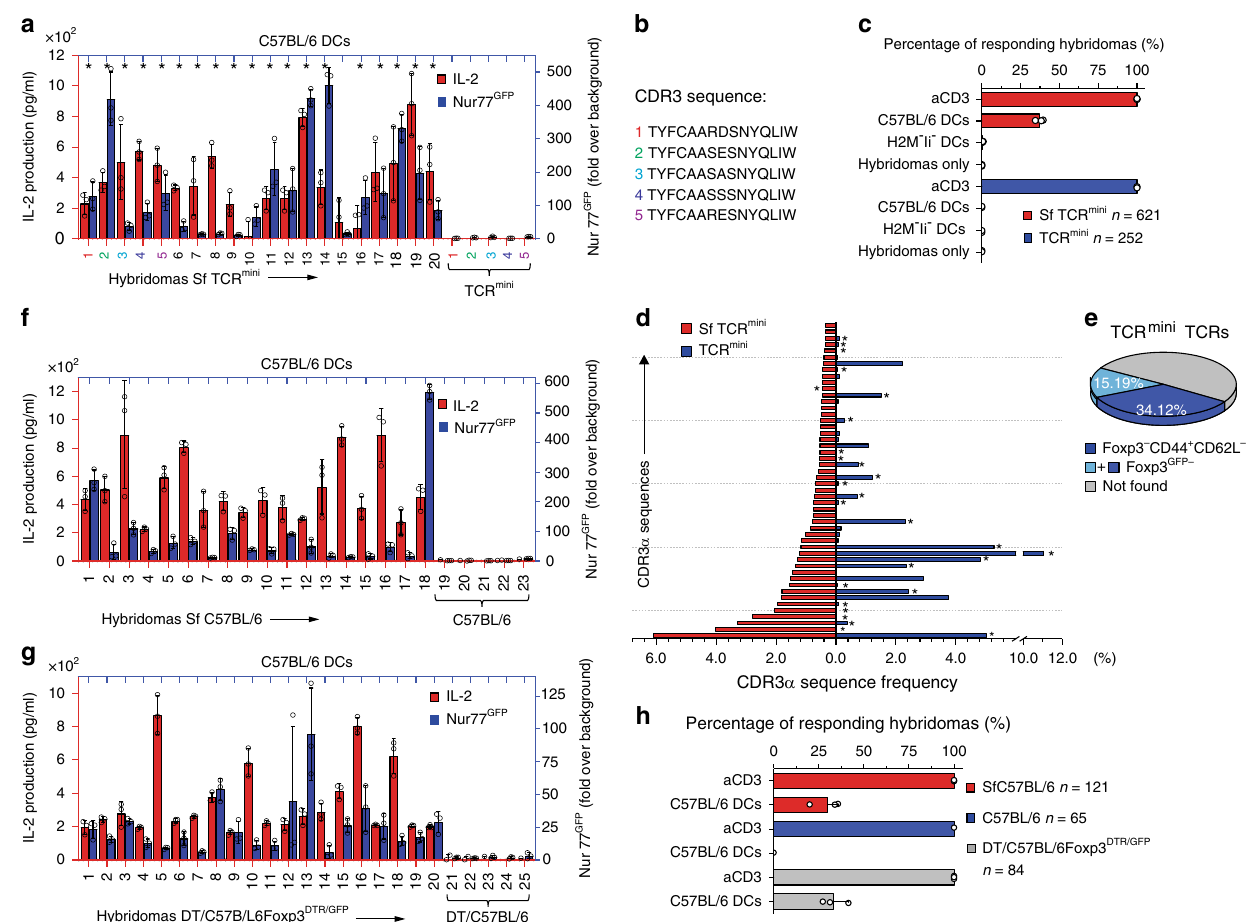
Fig. 3 Hybridomas from SfCD4 + Foxp3 GFP − cells are activated by C57BL/6 DCs. a IL-2 production (red bars) and Nur77 GFP expression (navy bars) by representative hybridomas (#1-20) from SfTCR mini mice. Hybridomas were stimulated overnight by autologous DCs. The last 5 hybridomas (marked by colored #1-5) were established from TCR mini mice and expressed the same fi ve TCRs as fi rst hybridomas #1-5 from SfTCR mini mice. Stars mark hybridomas whose TCRs are also expressed by naive CD4 + Foxp3 GFP − cells in healthy TCR mini mice. b Sequences of TCR α CDR3 regions from hybridomas marked # 1- 5. For other TCR α CDR3 sequences see Supplementary Data 5. c One-third of hybridomas derived from CD4 + Foxp3 GFP − SfTCR mini effectors recognize peptides presented by A b wt, but not empty A b on DCs from H2-M - Ii − mice. Bars show % of responders of the total number of tested hybridomas from each strain. d Top fi fty dominant TCRs expressed by Sf effectors (CD4 + CD44 + CD62L − Foxp3 GFP − ) in LNs, and these TCRs frequencies on CD4 + Foxp3 GFP − cells in the same organ in TCR mini mice (for sequences see Supplementary Data 6). Stars (*) mark TCRs also expressed by SfCD4 + cell hybridomas that responded ex vivo to autologous DCs. e TCRs retrieved from autoreactive SfCD4 + Foxp3 GFP − hybridomas account for a major fraction of TCRs expressed by peripheral CD4 + Foxp3 GFP − cells from healthy TCR mini mice. f IL − 2 production and Nur77 GFP expression by representative hybridomas from SfC57BL/6 mice (#1 – 18) or healthy C57BL/6 mice (#19-23). Hybridomas were activated as indicated in (a). g IL − 2 production and Nur77 GFP expression by representative CD4 + Foxp3 GFP − hybridomas from toxin-treated C57BL/6 Foxp3 DTR/GFP (#1-20) or DT-treated control mice (#21-25) after o/n co-culture with autologous DCs. Error bars are standard error across 3 SD replicas. h Percent of all tested hybridomas from Sf and control C57BL/6 or toxin treated C57BL/6 Foxp3 DTR/GFP that responded to activation by autologous DCs. Bars represent % of responders of total number of tested hybridomas from each strain. Source data are provided in a Source Data fi le. Error bars shown as SD